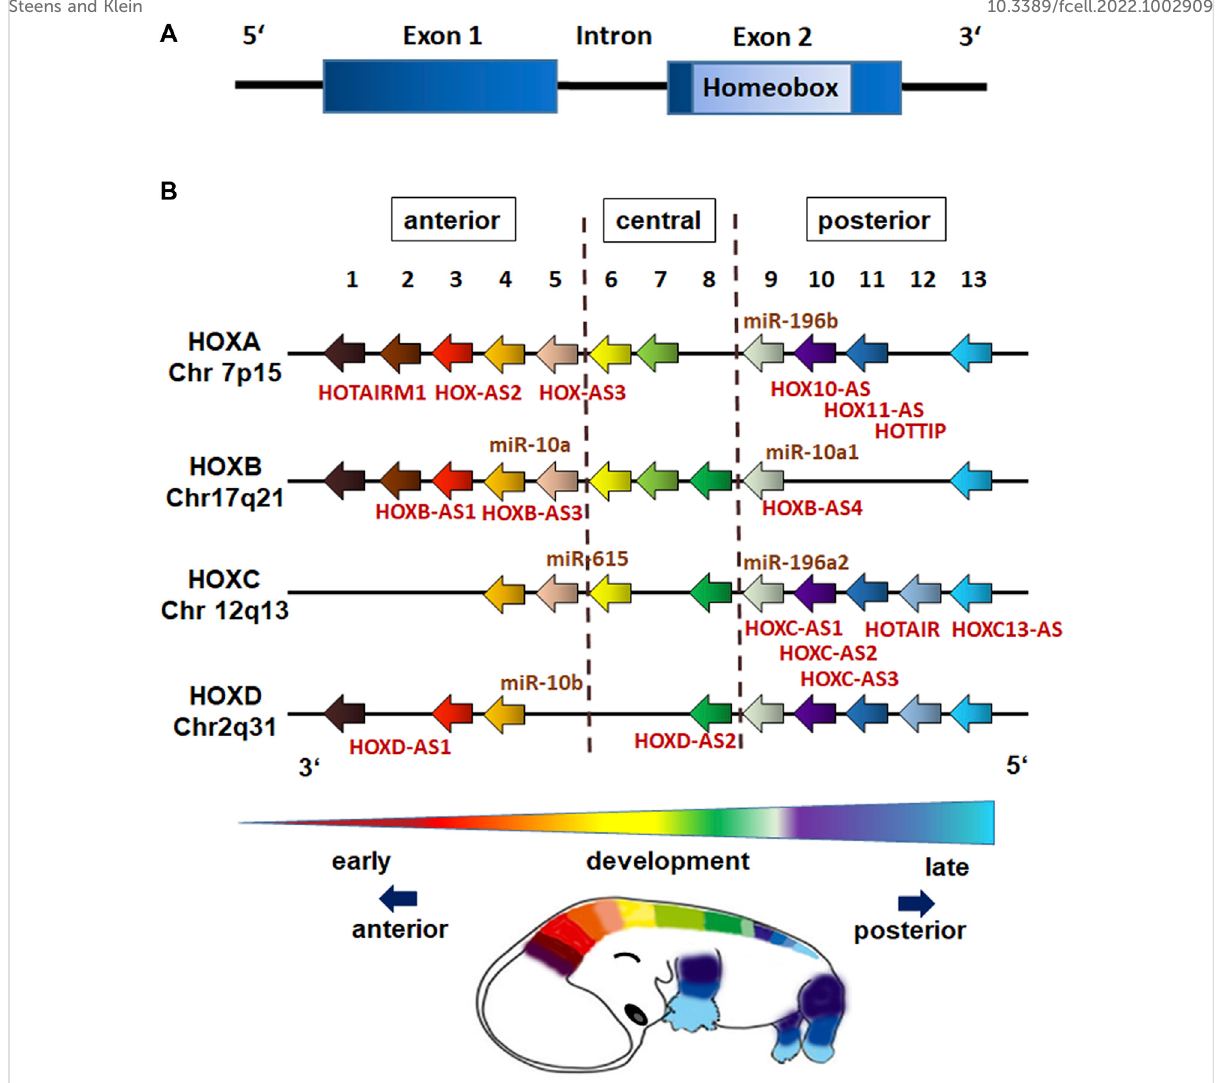
FIGURE 2 HOX gene structure and genome organization (schematic representation). (A) HOX genes are comprised of one intron separating two exons with the second exon having a 120-nucleotide sequence encoding for the 60 amino acid DNA-binding domain known as the homeobox (homeodomain). (B) The39humanHOX genesareclustered into thefourHOXfamiliesHOXA, HOXB,HOXC,andHOXD witheachfamilyconsisting of nine to eleven paralogous genes (assigned by numbers based on sequence similarity and cluster position), which are responsible for the anterior-posterior speci fi cation of body segments. The position of non-coding RNAsthat are interspersed within the coding HOX genes are marked (miR,microRNAs; AS, antisense RNAs). HOX gene expressions exhibit spatial and temporal collinearity: nested domains of HOX genes are generated with anteriorly HOX expressions operating earlier in development and posteriorly HOX expressions occurring